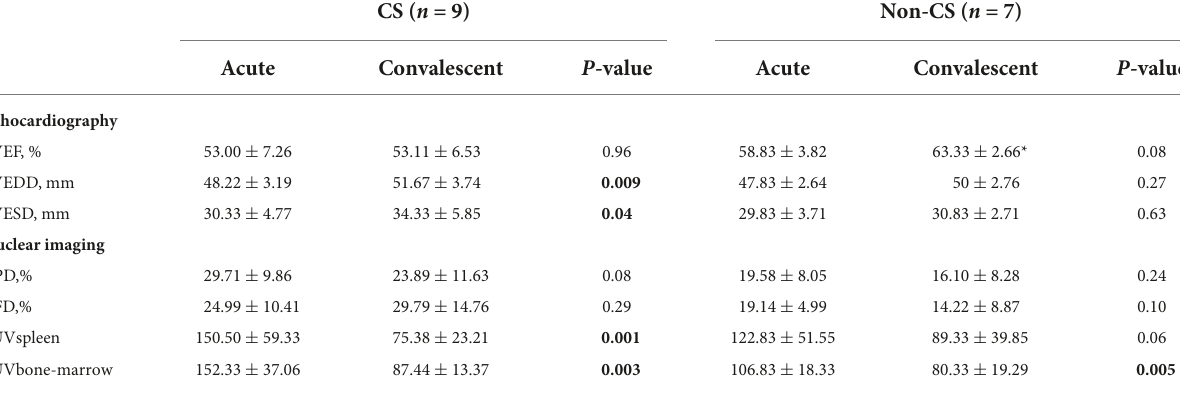
TABLE 3 Comparisons between the acute and convalescent (3-month post myocardial infarction) imaging in patients with- and without cardiogenic shock.